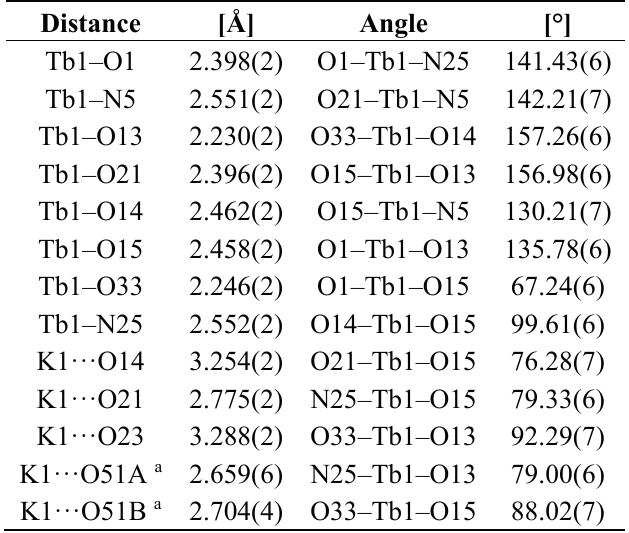
Table 2. Selected interatomic parameters [Å, °] for complex 2 .